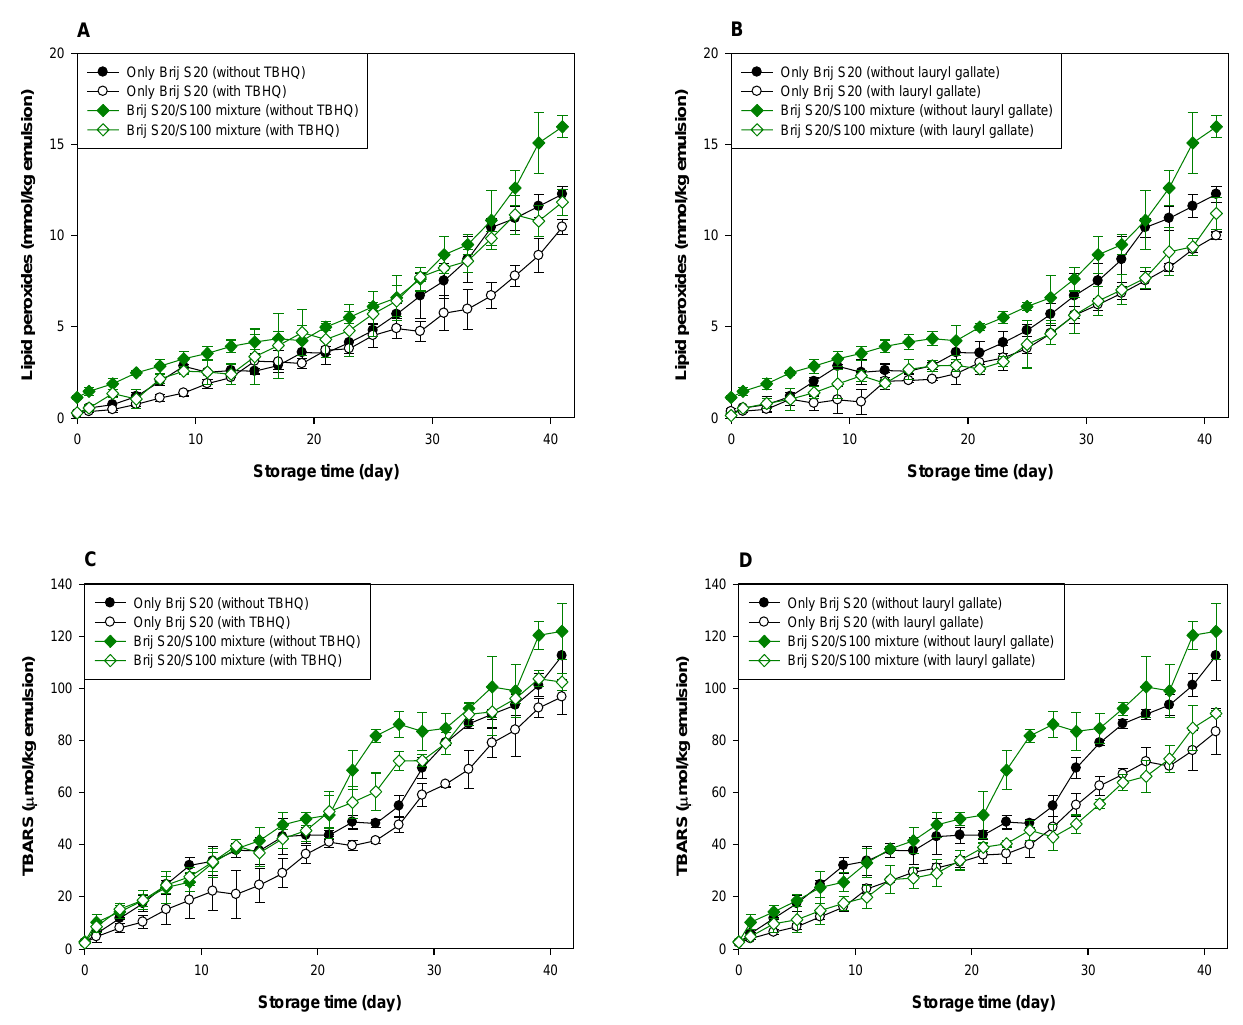
Figure 3. Effects of TBHQ (( A ) and ( C )) and lauryl gallate (( B ) and ( D )) on the evaluation of lipid peroxides (( A ) and ( B )) and TBARSs (( C ) and ( D )) in emulsions stabilized with the mixture of Brij S20 and S100 at a surfactant concentration of 2.93 mM at pH 3.